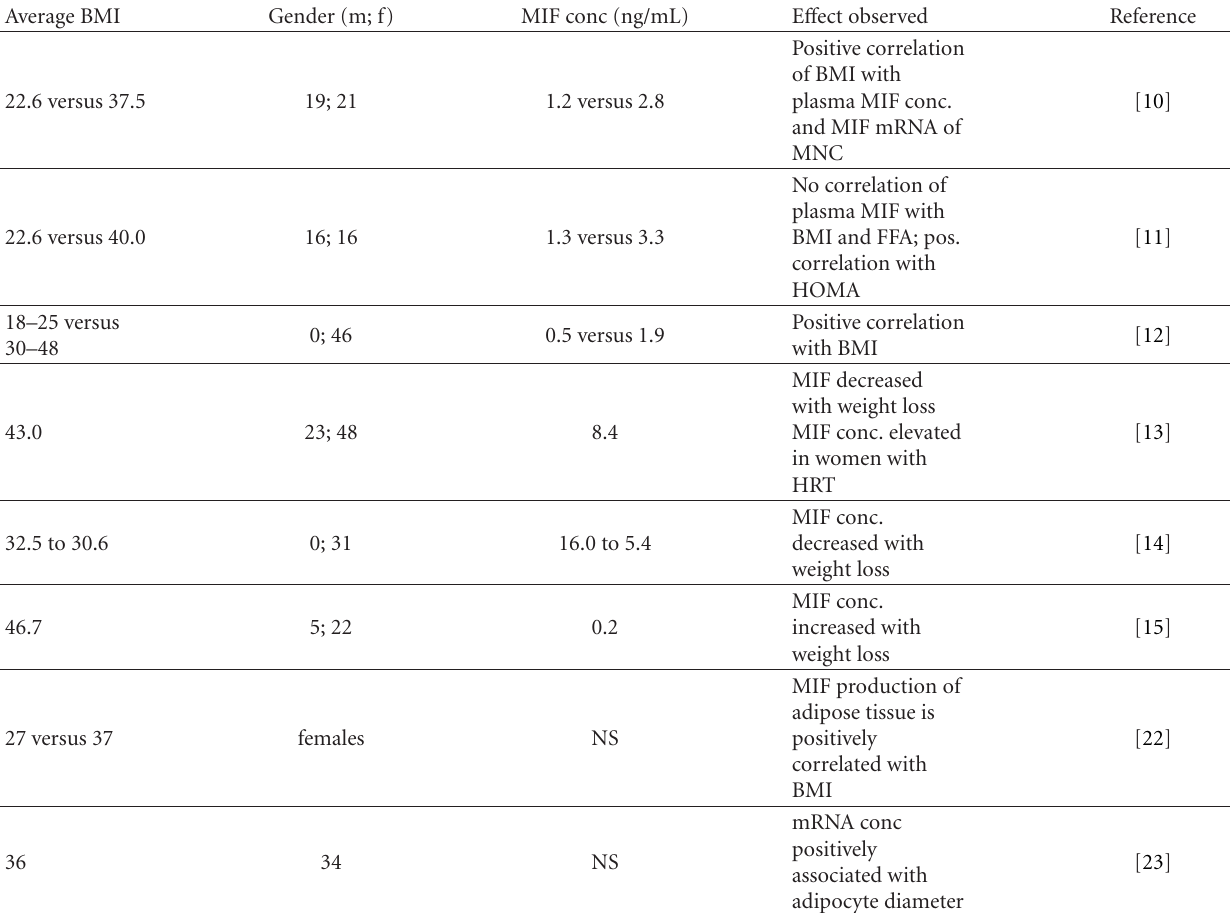
Table 1: Relationship between plasma MIF concentrations and body mass index in human studies. Studies are listed on basis of increasing body mass index (BMI). The plasma MIF concentration is provided together with the number of male (m) and female (f) participants and the major e ff ects observed. NS: not